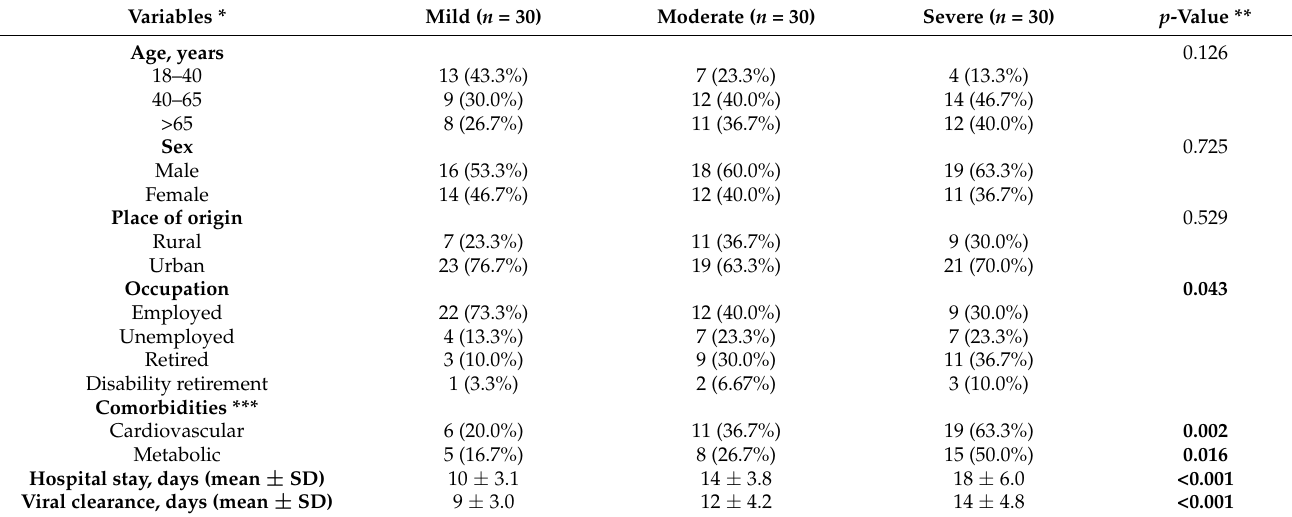
Table 2. Background data of study participants by the severity of